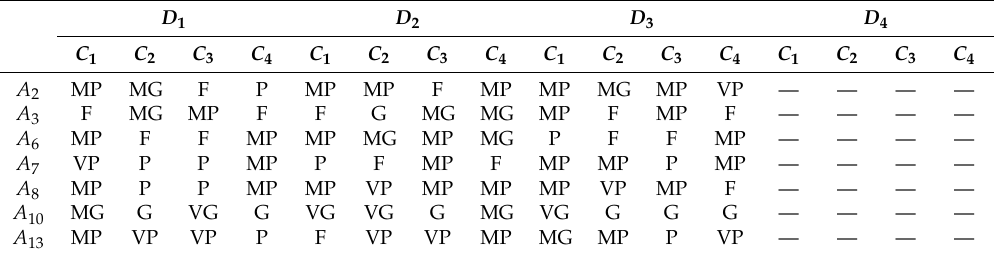
Table 5. The decision-matrix of each decision-maker at fourth period ( t = 4).